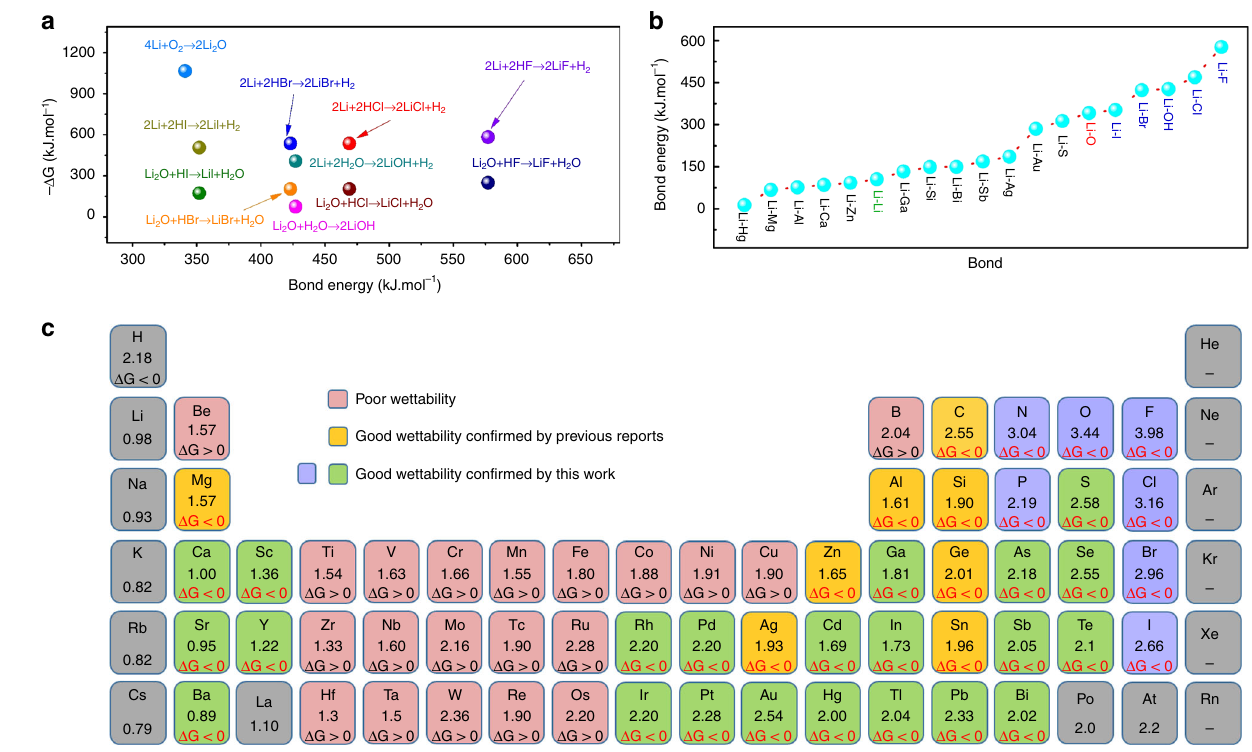
Fig. 4 Common characteristics of wettability onto various lithiophobic substrates. a Δ r G for some feasible reactions at 250°C to improve the wettability. b Bond energies of the newly formed bonds. c Electronegativities of various elements in the periodic table and Δ r G of elements or compounds reacted with the molten Li. The elements in green and blue colors represent the elements could react with molten Li at the temperature of 180 – 300 °C, and form new chemical bonds, which is responsible for the improved wettability